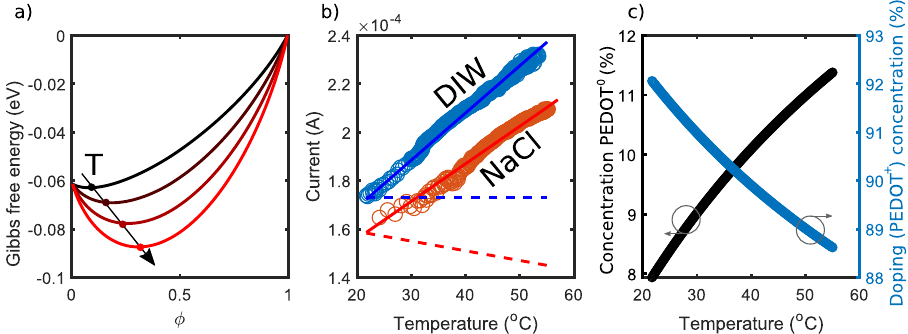
Fig. 2 | Thermodynamics of OMIECs. a Temperature and ϕ dependence of the Gibbs free energy (with H mix =0, using μ p + = (cid:1) 60 meV = mol and μ p 0 =0). Higher temperatures shift the minimum towards ϕ 0 =0.5 and to lower energies. b Measurement of the current fl owing in a PEDOT:PSS thin- fi lm at a different temperatures, in deionized water (DIW) and saltwater DIW:NaCl 100mM (circles). Curves are fi tted with a linear regression (solid lines). The experiment in DIW (see Methods for details) is used to estimate the contribution of the temperature-